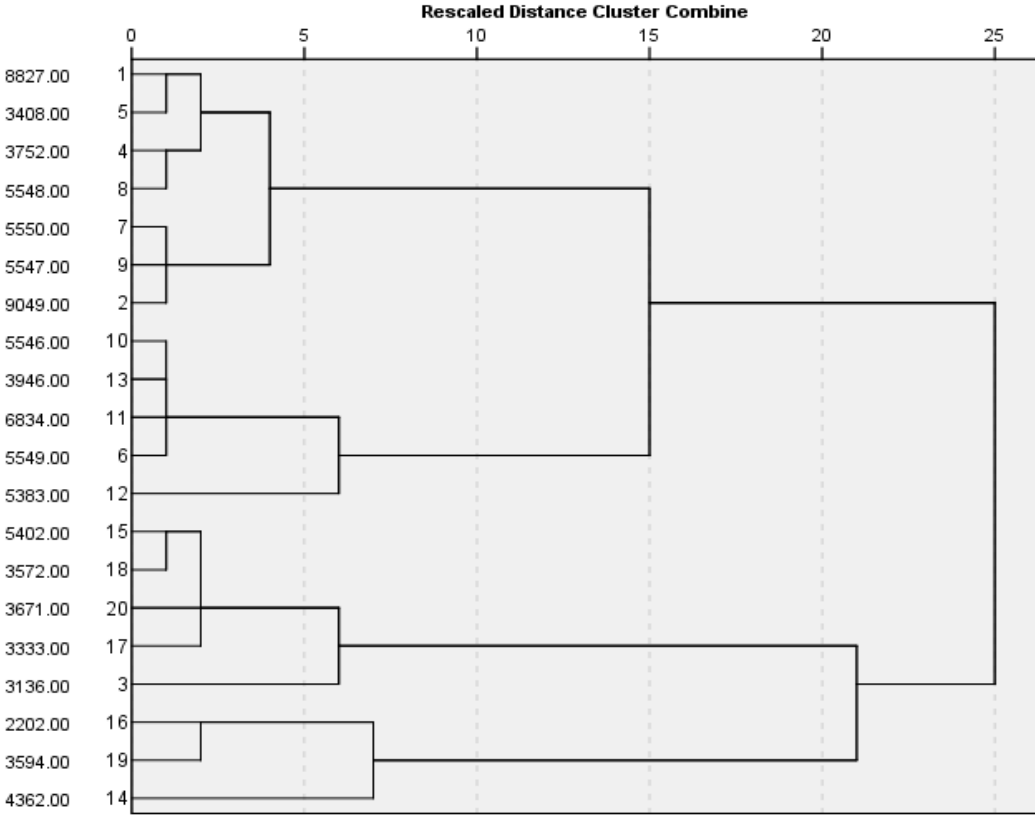
Figure 1 : Dendogram of Pachchaperumal and Suduru samba accessions derived through Ward’s linkage method of Cluster Analysis based on days to flowering and 12 morphological